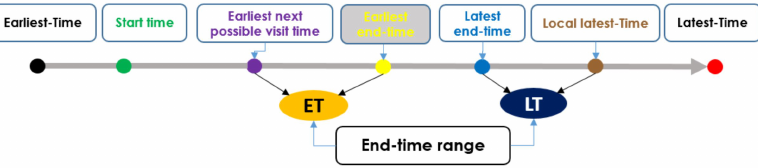
Figure 19. Updated end-time range: the final end-time range is generated, which includes the constraints EVT and LLT on the initial end-time range; therefore, the range-bounds are